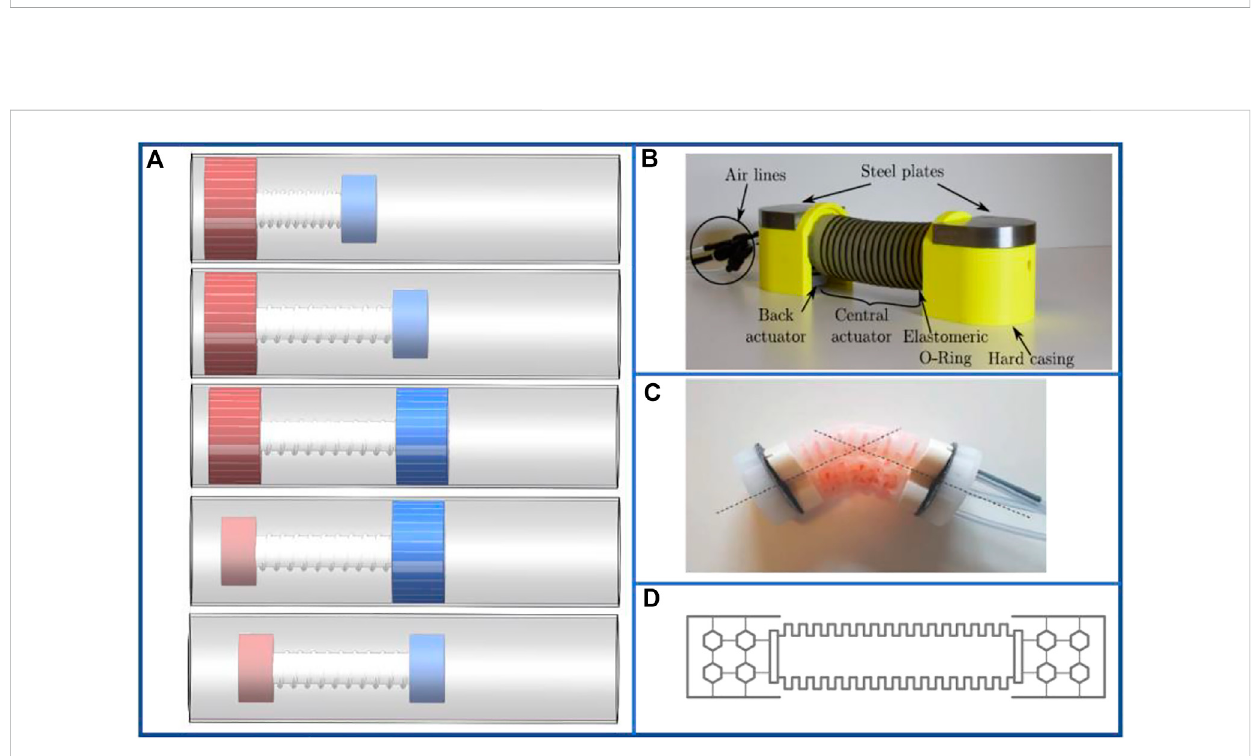
FIGURE 4 Examples of various structures of pneumatic-driven single-segment earthworm-inspired soft robot. (A) Fiber-covered pneumatic-driven robot schematic and order of actuation for peristaltic motion. (B) Con fi guration of surface crawling pneumatic-driven robot (Joey et al., 2017). Reproduced from Ref. (Joey et al., 2017). with permission. (C) Bending diagram of pneumatic-driven robot for pipe inspection with VAMP structure (Hu and Cheneler, 2021). Reproduced from Ref. (Hu and Cheneler, 2021). with permission. (D) Structural diagram of pneumatic-driven robot with cellular